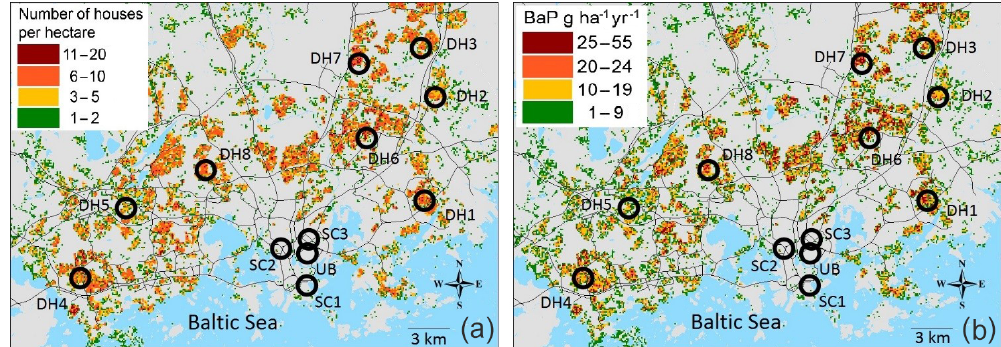
Figure 1. Air quality monitoring sites (diameter of circles 1km): (a) the density of detached and semidetached houses and (b) estimated yearly BaP emissions from wood combustion in the Helsinki metropolitan area in 2014. The main road network is shown for